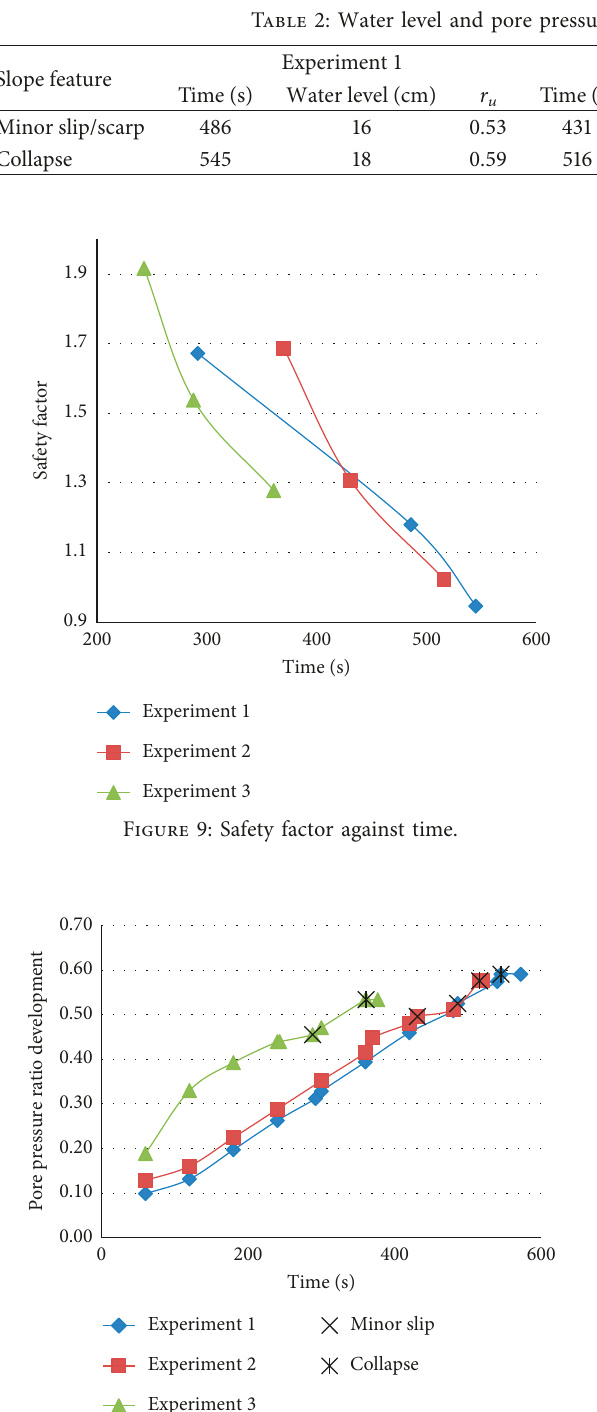
Figure 10: Pore pressure ratio development along toe against time.